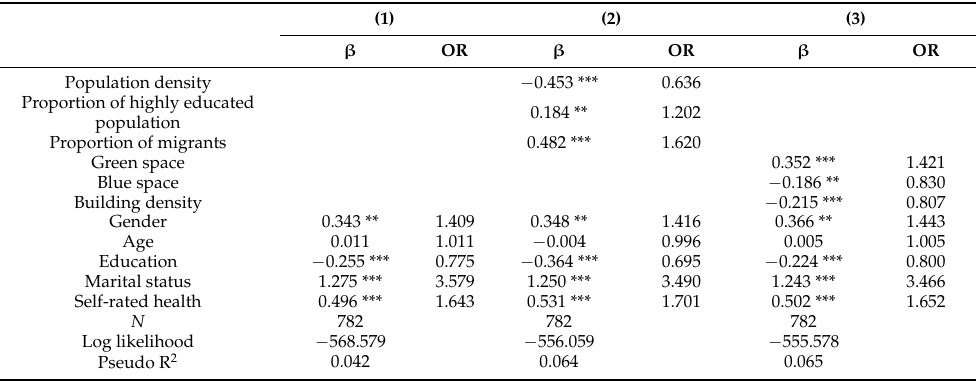
Table 2. The results of Ologit models of long-term residential environment exposure and subjective wellbeing in later